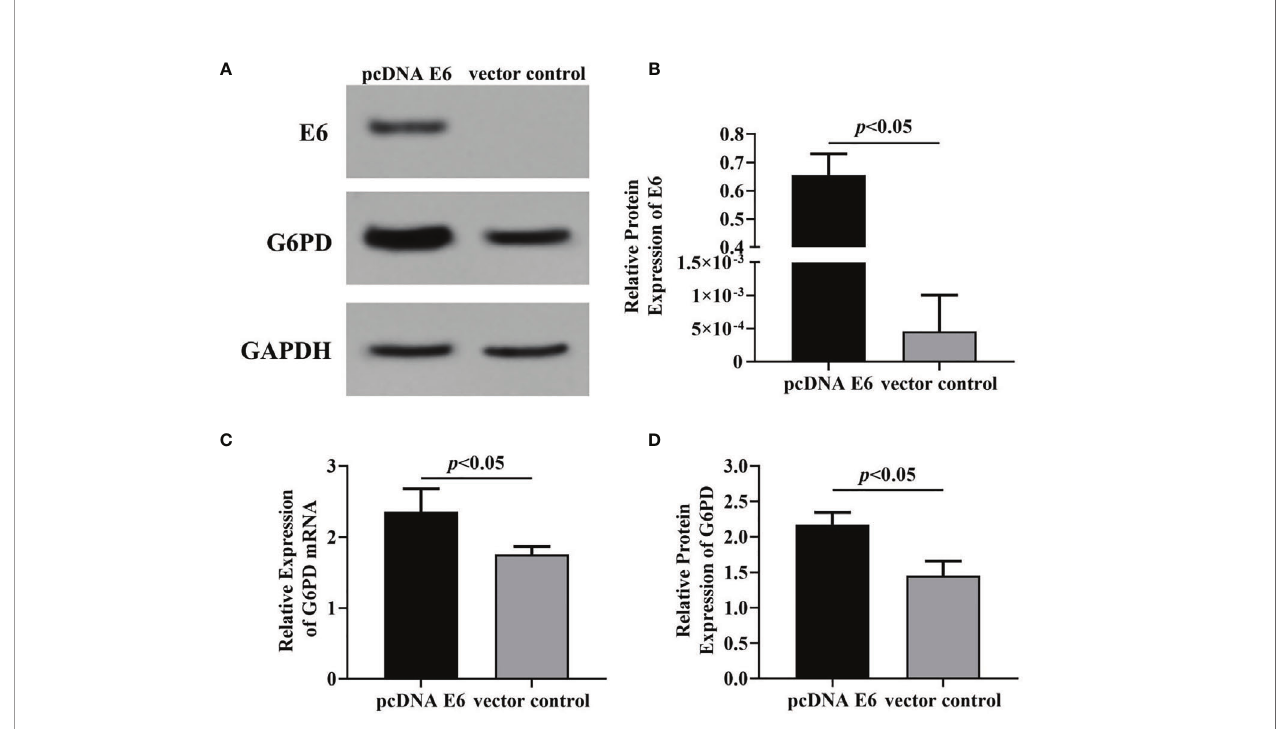
FIGURE 2 | The effects of HPV16 E6 on G6PDexpression.Forty-eight hoursafter plasmid transfection,the levelsof E6 protein and G6PD mRNA/protein in HeLa cellswere detected.The expression levels of E6 protein (A, B) and G6PDmRNA/protein (A,C,D) were indicated byWestern blots orRT-qPCR,respectively. (A) , representative blots from two groups. Statistical plots ofthe relative expression of E6 protein (B) , G6PDmRNA (C) , and protein (D) . Data are presented as means± SD ( n =